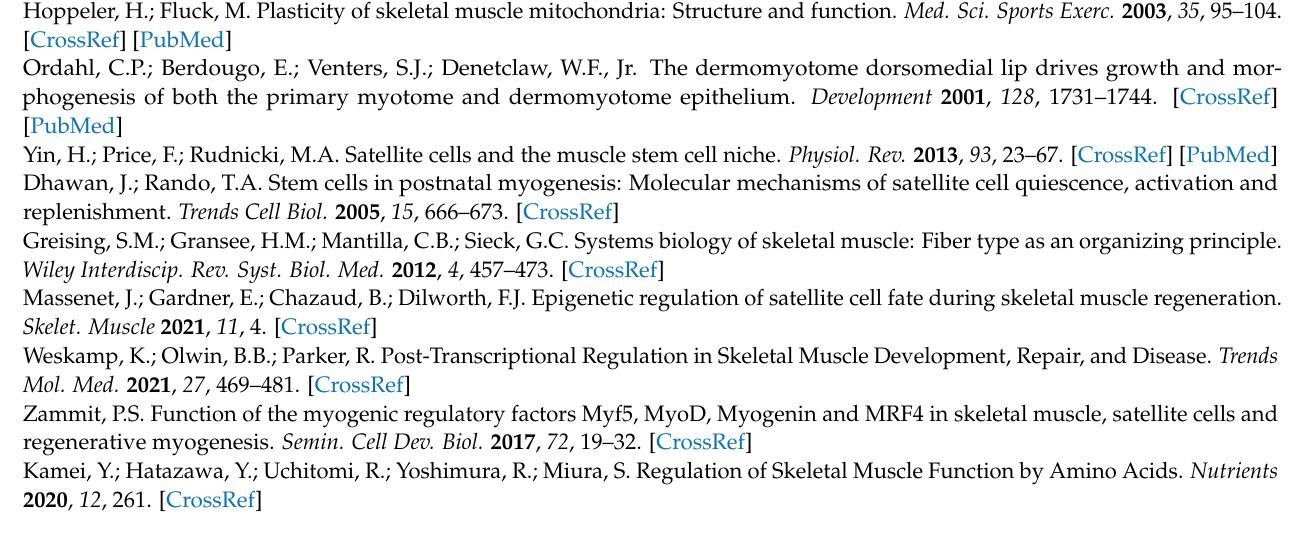
results; Table S2: List of all differentially expressed genes; Table S3: Biological processes, cellular com- ponents, and molecular functions associated with upregulated genes; Table S4: Biological processes, cellular components, and molecular functions associated with downregulated